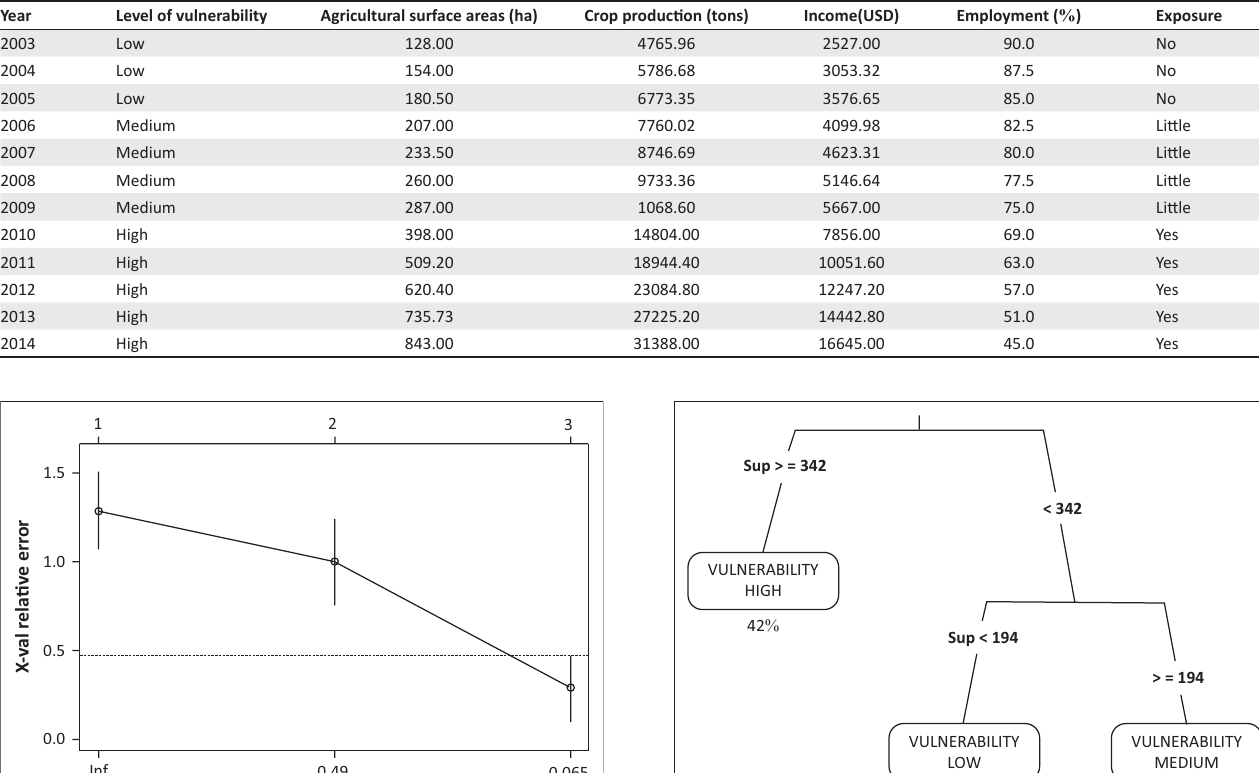
TABLE 5: Input variables for the Classification and Regression Tree model.